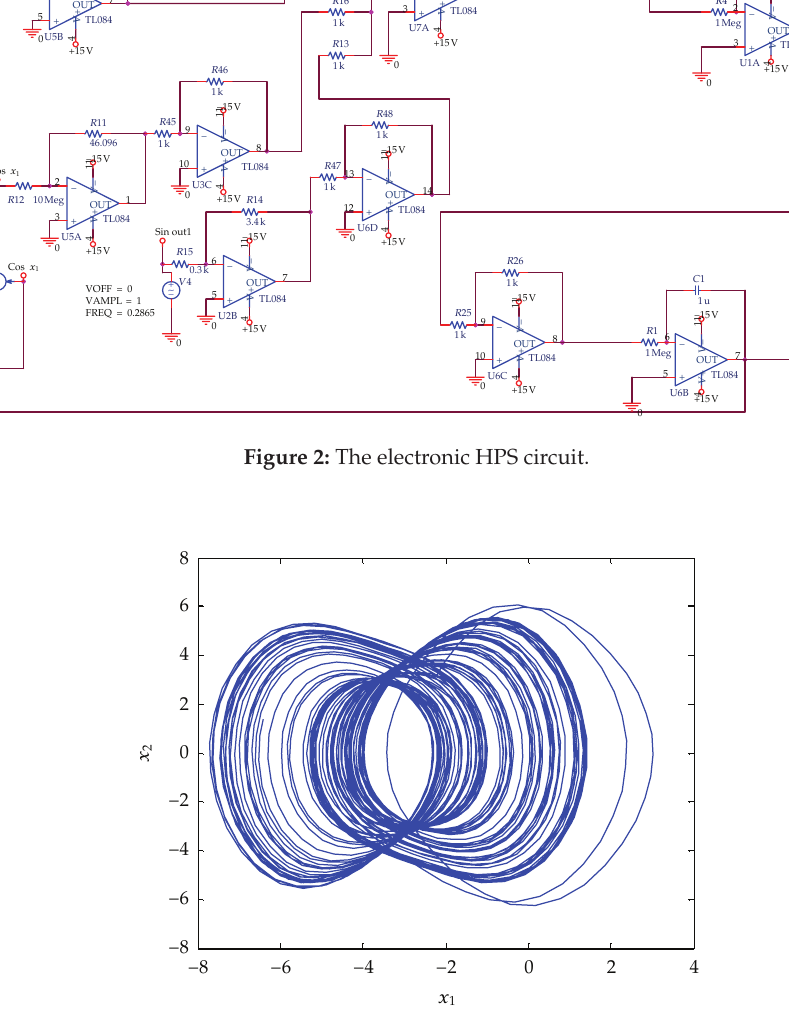
Figure 3: The simulation of HPS in phase